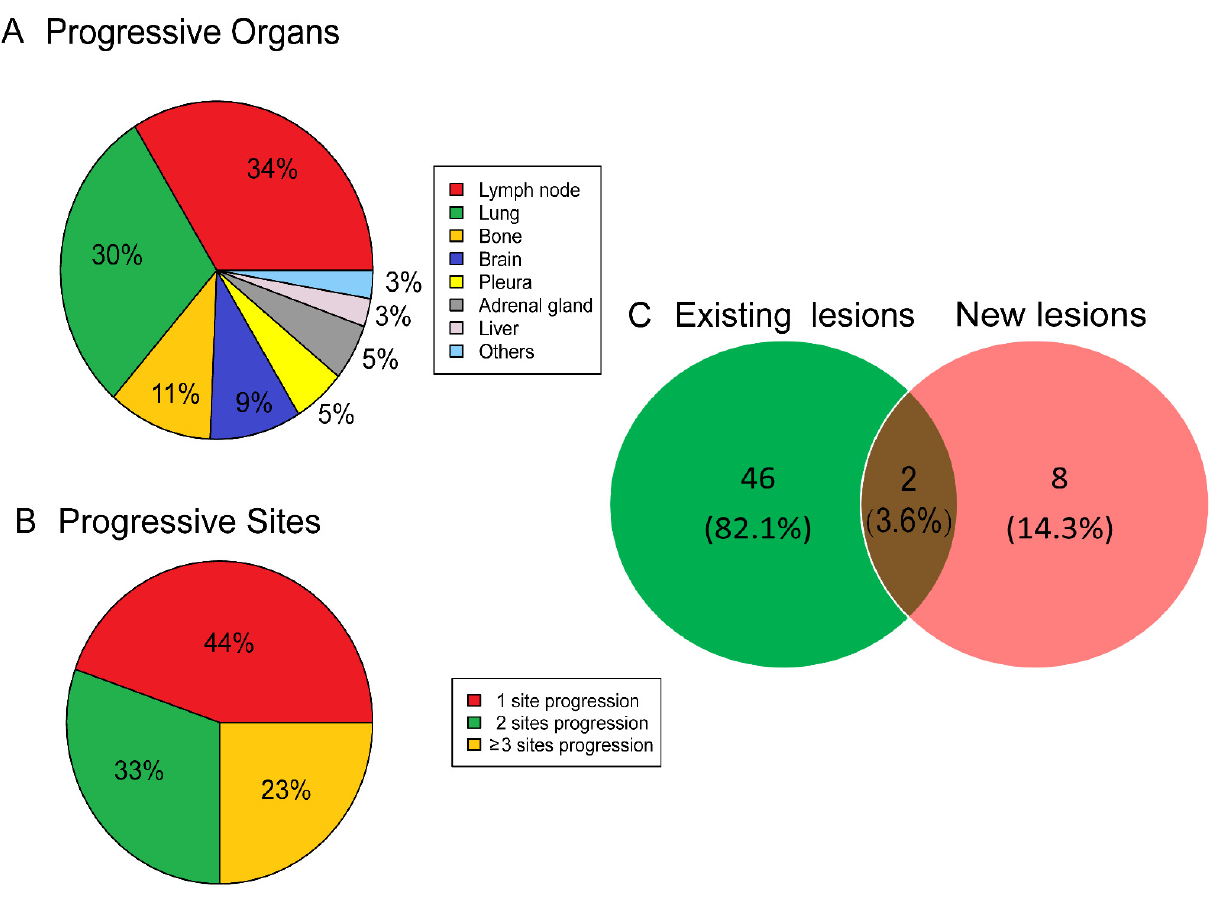
Figure 2. Progressive patterns of AR. Locations ( A ), number ( B ), and originations ( C ) of the progres- sive tumor lesions in patients with AR. sive tumor lesions in patients with